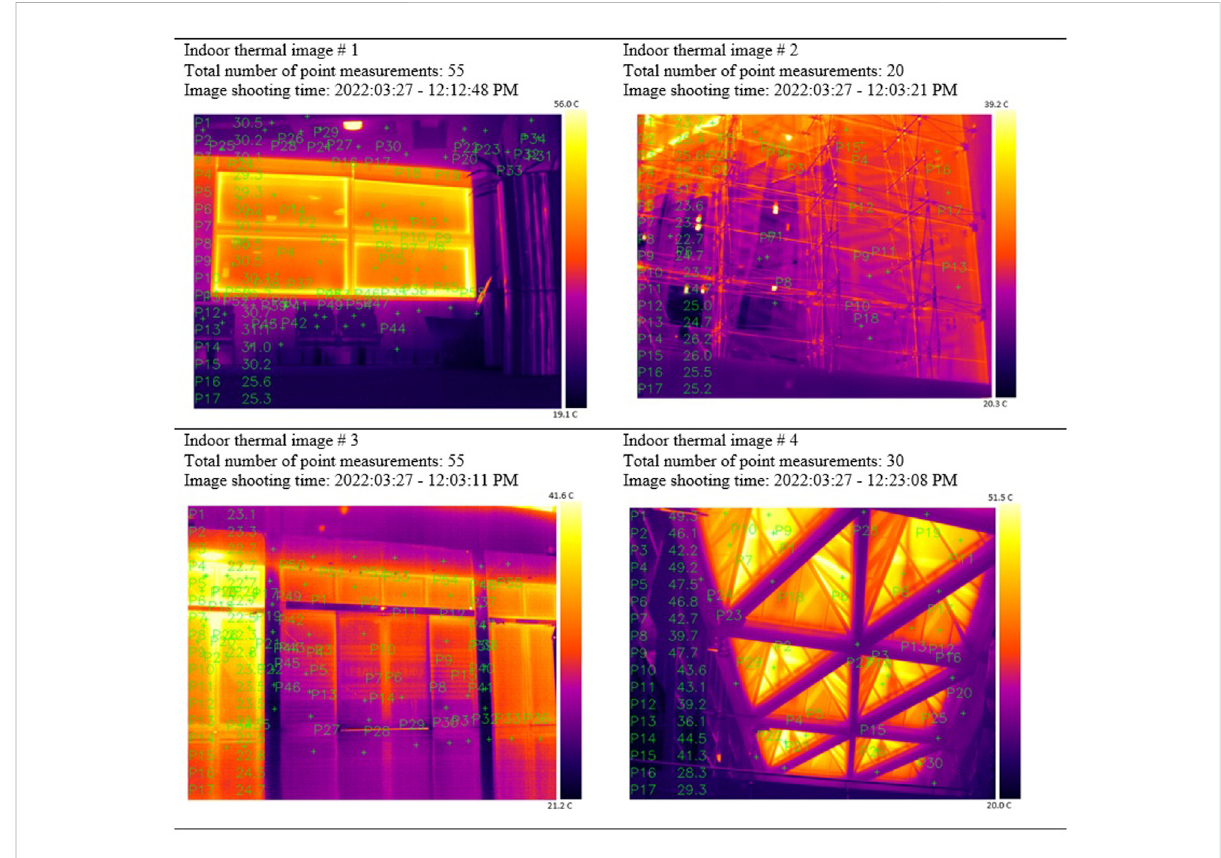
FIGURE 6 Thermal imaging measurements for the B indoor